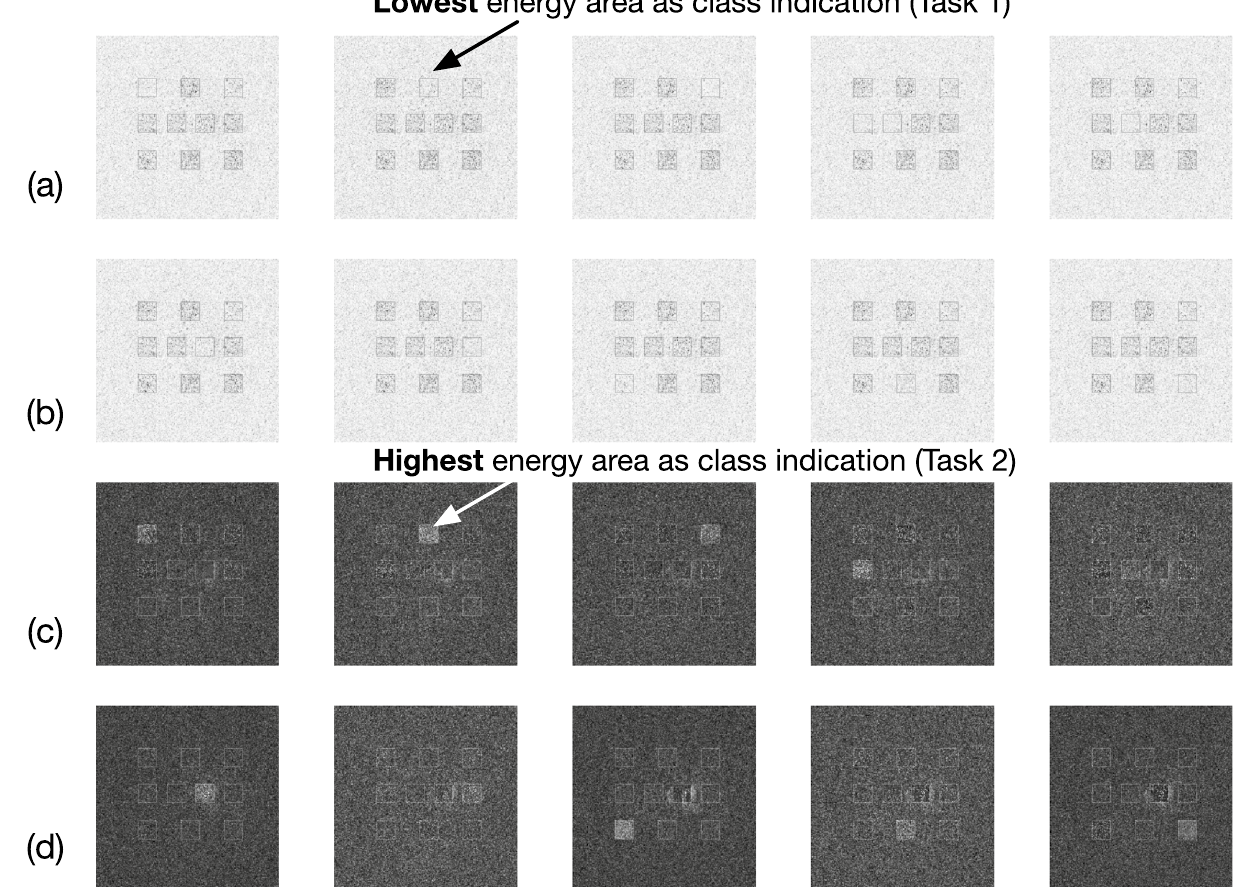
Figure 2. Modeling of ten classes for two different datasets with ten detectors. ( a , b ) One-hot encoding for classes 0–9 of the first task (MNIST) represented using the energy value observed at the detectors. Final classes are produced using the index of the lowest energy area, i.e., argmin ( det ). ( c , d ) One-hot encoding for classes 0–9 represented of the second task (e.g., Fashion-MNIST) using the energy value observed at the detectors. Final classes are produced using the index of the highest energy area, i.e., argmax ( det